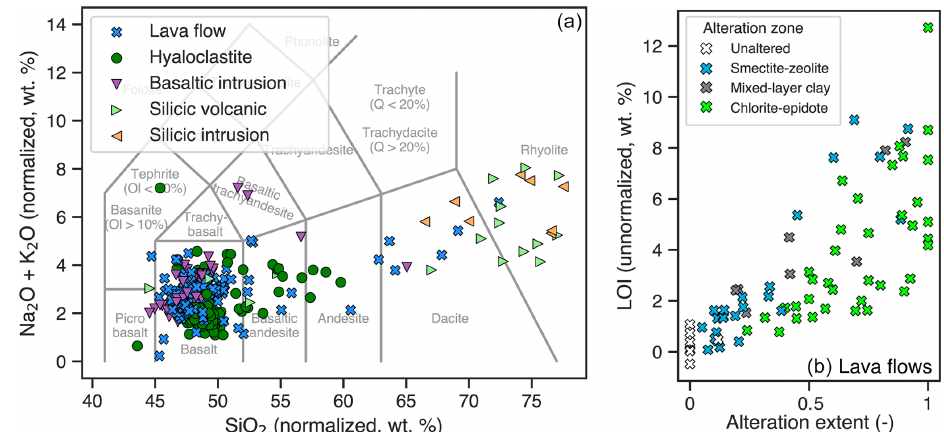
Figure 8. Whole-rock geochemical data and petrographic observations of alteration. Panel (a) presents a total alkali–silica (TAS) diagram (Le Maitre et al., 2002), with samples colored by lithology; note that many of the rocks are very altered and that lithologic identifiers are assigned based on the interpretation of the geological context and visual characteristics, rather than the geochemical field into which the rock plots. Panel (b) shows the loss on ignition (LOI) versus the total extent of alteration quantified by point counting; only lava flows are shown, and symbols are colored by alteration